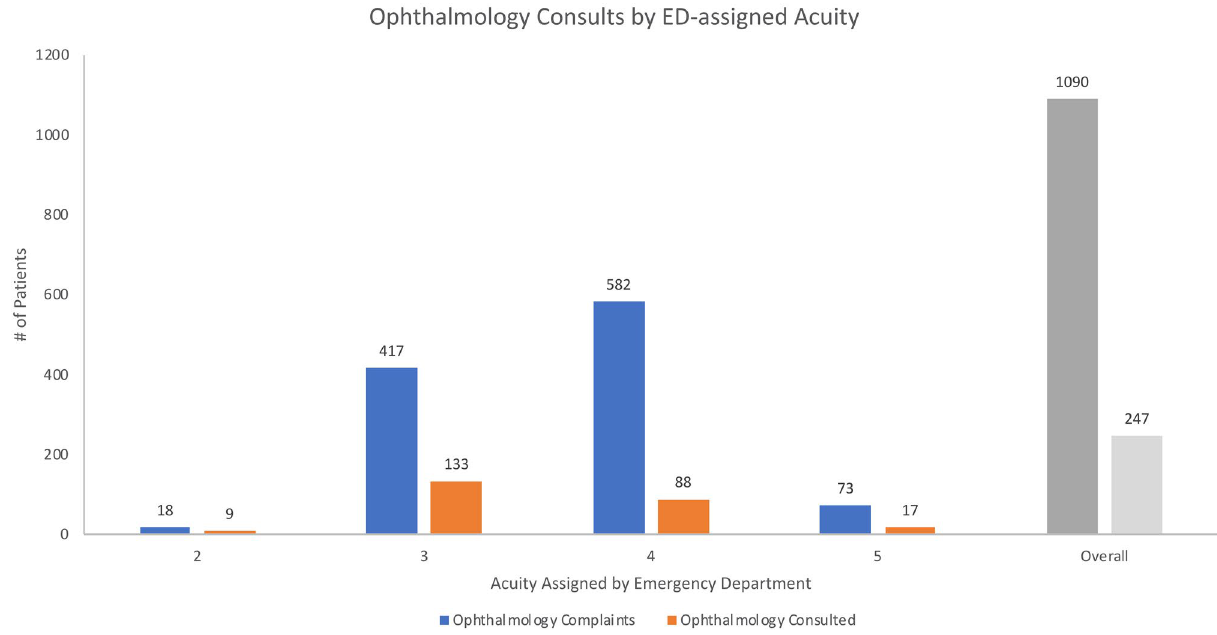
Figure 2. Breakdown of ophthalmology complaints and consults by initial ED-assigned acuity.